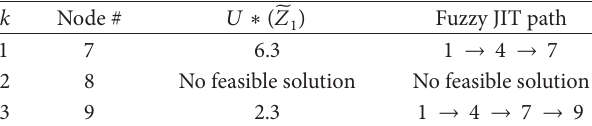
Table 3: The fuzzy JIT paths to the service